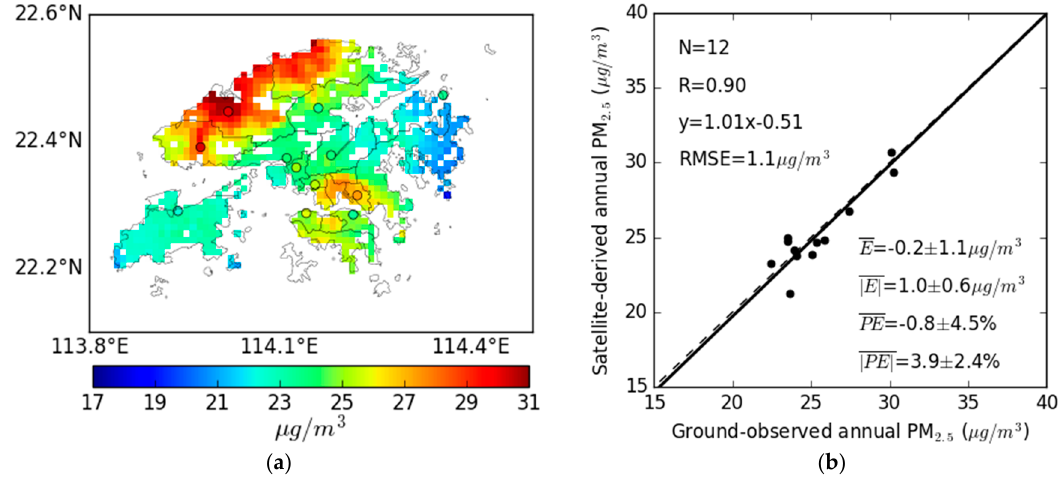
Figure 2. ( a ) Spatial distribution of the satellite-derived PM 2.5 concentration at a resolution of 1 km in the residential areas of Hong Kong in 2015. The points represent ground observations at 12 general stations. ( b ) Evaluation of the satellite-derived PM 2.5 concentration against the ground observations.